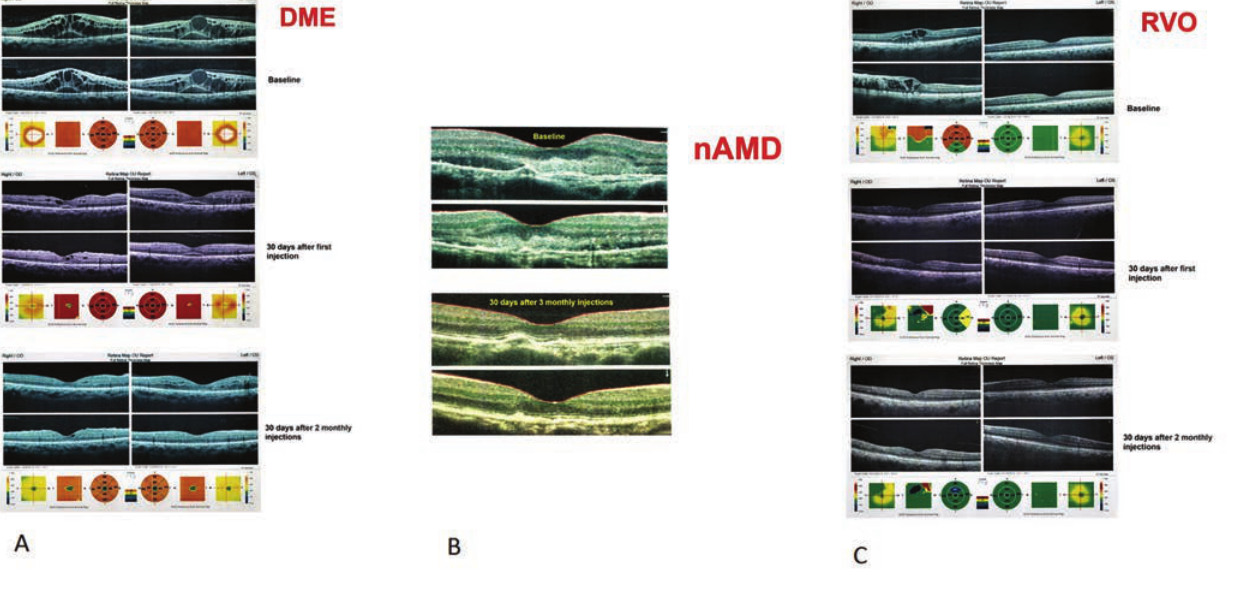
Figure 3. Response to Stivant® injections; samples from each subgroup (DME, nAMD, RVO) under study